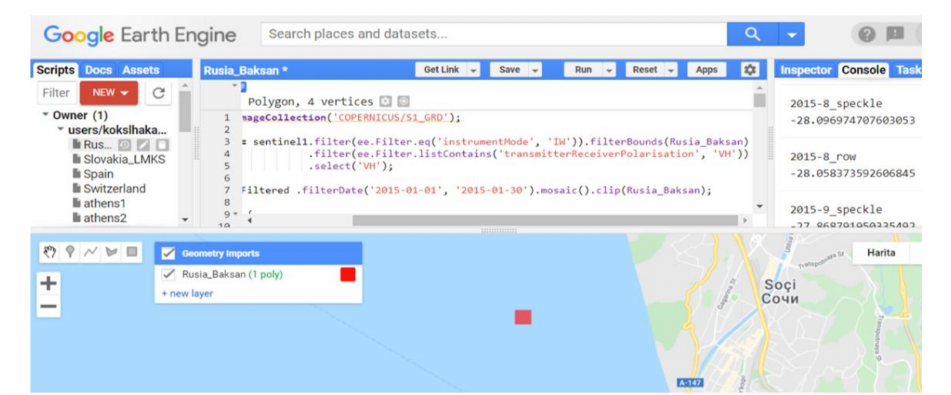
Figure 2. Processing of Synthetic Aperture Radar (SAR) image on Google Earth Engine Platform.